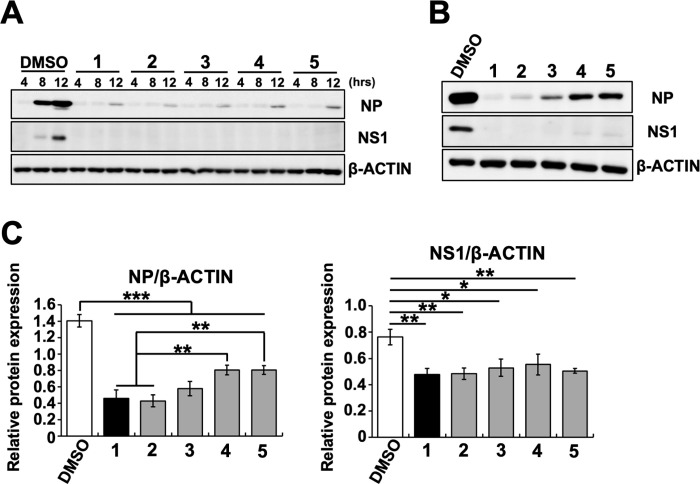
Cyclobakuchiols A–D inhibits the expression of influenza A viral proteins.Cyclobakuchiols A (2), B (3), C (4), and D (5) (12.5 μM), DMSO (0.125%), or (+)-(S)-bakuchiol (1) (12.5 μM) were mixed with A/PR/8/34 virus (MOI 0.1) and incubated for 30 min prior to the addition to 1 × 105 MDCK cells. (A–C) The levels of influenza A viral NP and NS1 proteins in cell lysates were analyzed by western blotting at 4–12 h (A) or 24 h (B) post-infection. β-actin protein was analyzed as an internal control. Signal intensities at 24 h post-infection were measured using ImageJ software, and the protein levels of NP/β-actin or NS1/β-actin were analyzed, while the protein levels of NP (C, left panel) (n = 3 each) and NS1 (C, right panel) (n = 3 each) were normalized to that of β-actin. Data represent the mean ± SEM and are representative of three independent experiments. *p < 0.05, **p < 0.01, ***p < 0.001 for the indicated comparisons. The results were reproducible in this experiment.